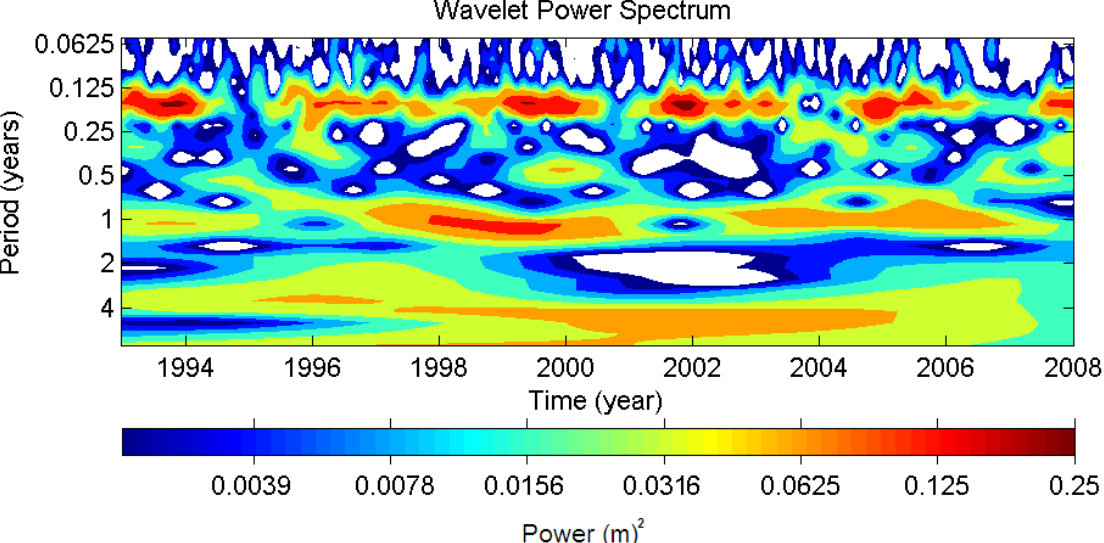
Figure 6. The wavelet power spectrum. The horizontal axis is the wavelet location in time and the vertical axis denotes the wavelet period in years. White patches denote power less than 0.0020 (m) 2